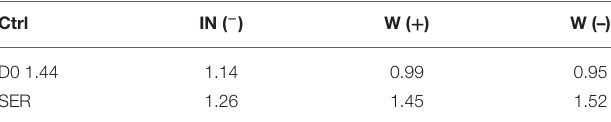
TABLE 2 | Dose enhancement effect.